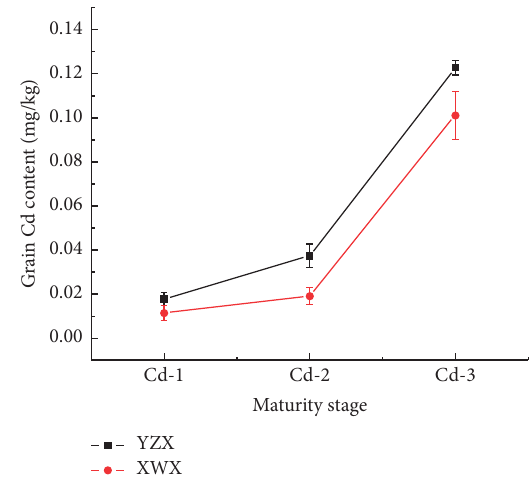
Figure 1: Variation trend of Cd content in seeds at maturity